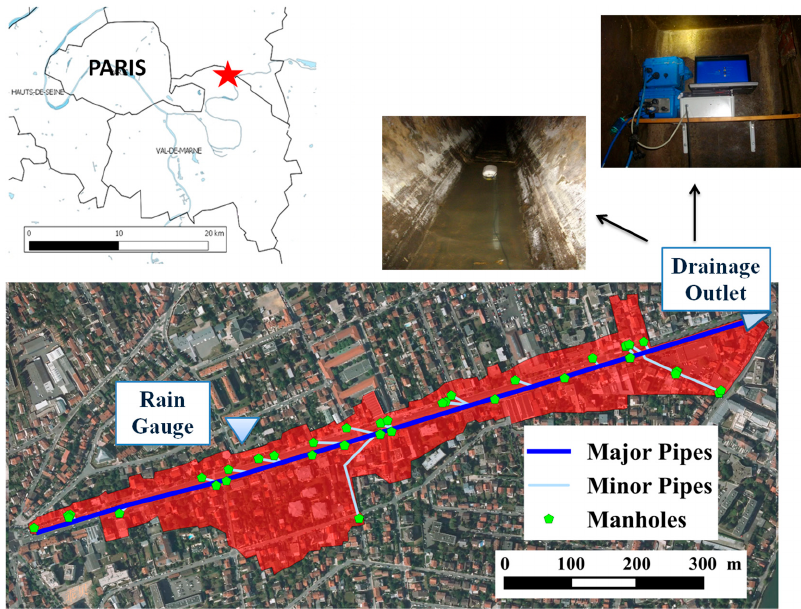
Figure 2. Delineated urban catchment of the study site, Le Perreux ‐ sur ‐ Marne, France.